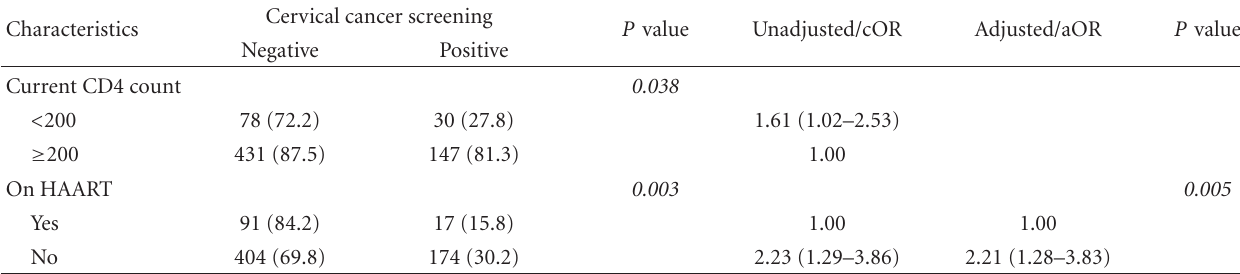
Table 3: Unadjusted and adjusted odds ratios of the multilevel logistic regression estimates for factors associated with precancerous cervical cancer lesions among HIV+ at Nazareth